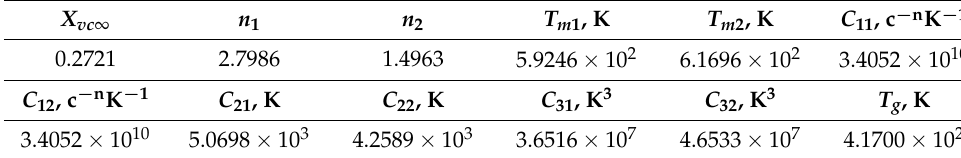
Table 1. Values of parameters of the PEEK material crystallization kinetics model.